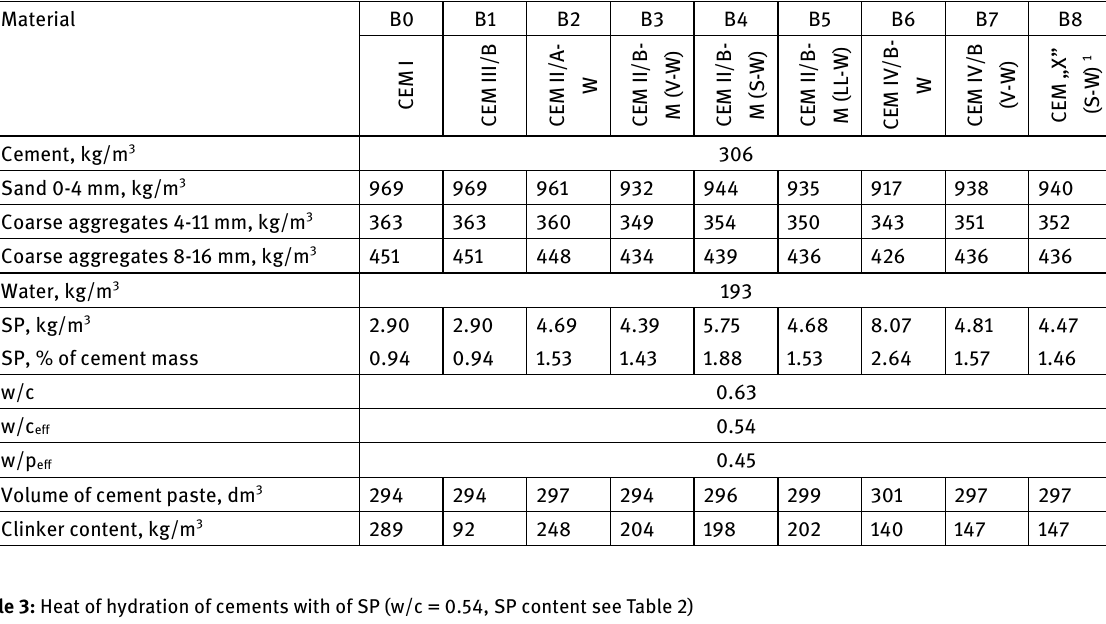
Table 2: Composition of concrete